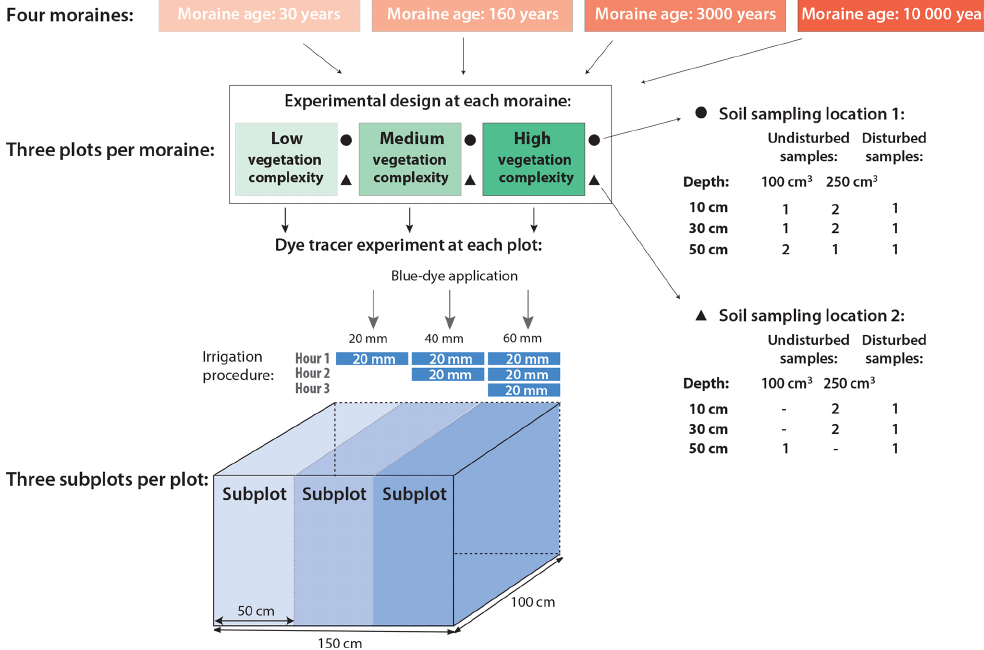
Figure 2. Illustration of the experimental design and soil sampling scheme at each